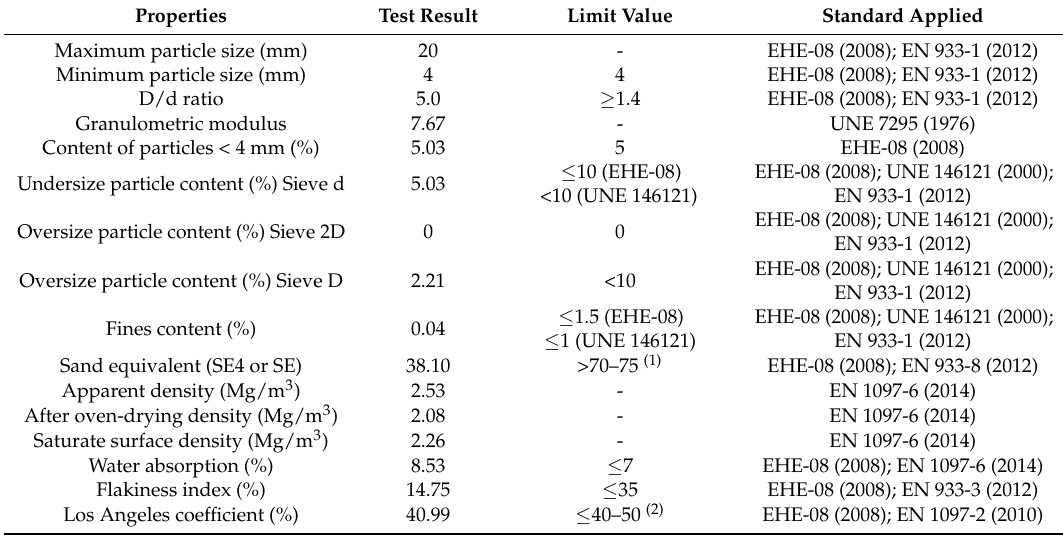
Table 1. Physical and mechanical properties of RMAc.